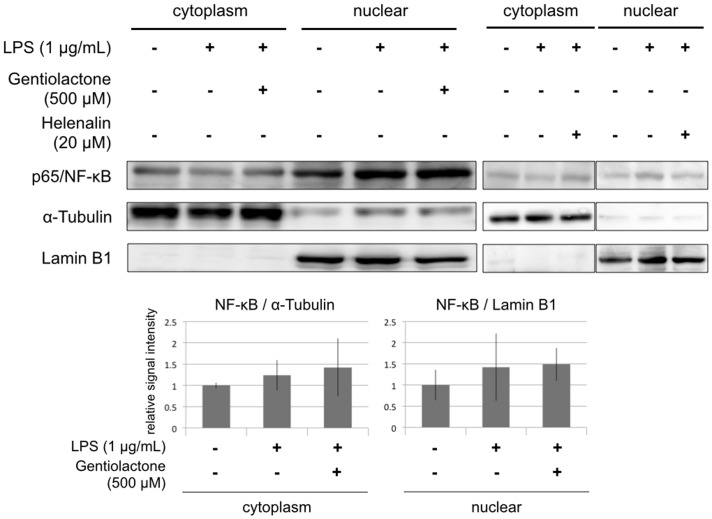
Gentiolactone does not inhibit nuclear transport of NF-κB.RAW264.7 cells were cultured for 1 hour with LPS (1 µg/mL) and gentiolactone (500 µM). The cytoplasmic or nuclear extracts were examined by immunoblotting analysis using anti-p65/NF-κB, anti-α-Tubulin or anti-Lamin B1 antibodies. Plotted values represent the mean value ± SD from four independent cultures. Helenalin was used as a positive control.